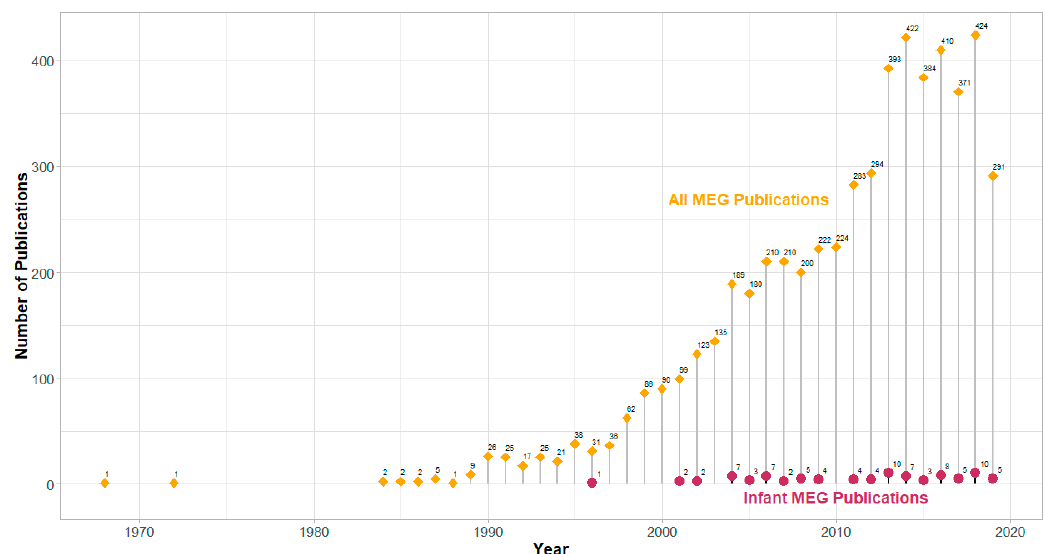
Figure 1. Number of magnetoencephalography (MEG) publications in the period of 1968–2019. Data were exported and replotted from the online PUBMED database (pubmed.gov; as of 21 July 2019) with search of target word “magnetoencephalography” in the title or abstract for “All MEG Publications”; and target words “magnetoencephalography” and “infant* or neonate* or newborn*” in the title or abstract for “Infant MEG Publications”.